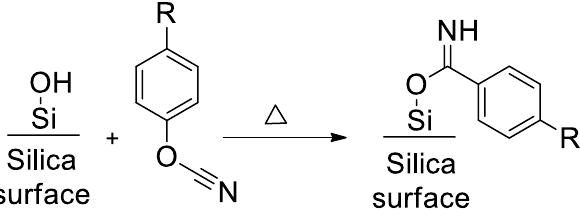
Figure 14. Scheme of formation of immobilized